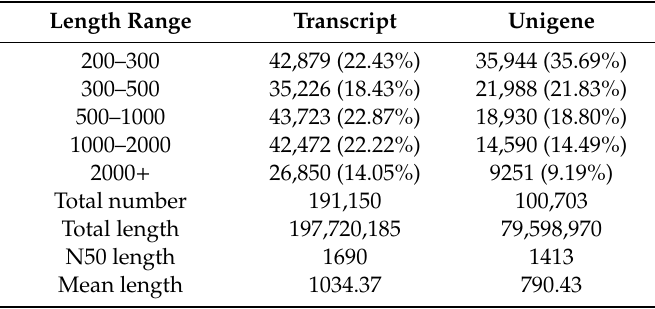
Table 1. Length distribution of the transcripts and unigenes clustered from de novo